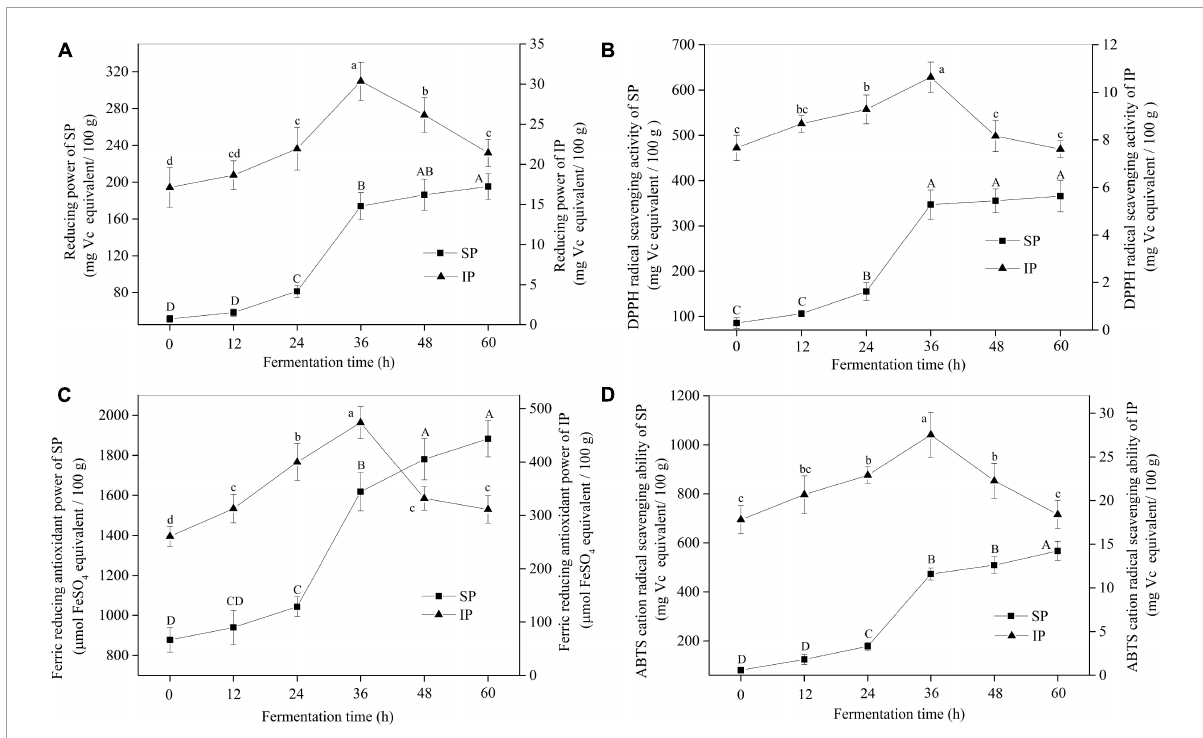
FIGURE3 The antioxidant activities of soybeans during SSF. (A) Reducing power; (B) DPPH radical scavenging activity; (C) ferric reducing antioxidant power; (D) ABTS cation radical scavenging ability. p < 0.05 was considered as the significant level. The small letters were used to show the significant difference between samples at different fermentation time for IP. The capital letters indicated the significant difference between samples at different fermentation time for SP. SP, soluble phenolics; IP, insoluble